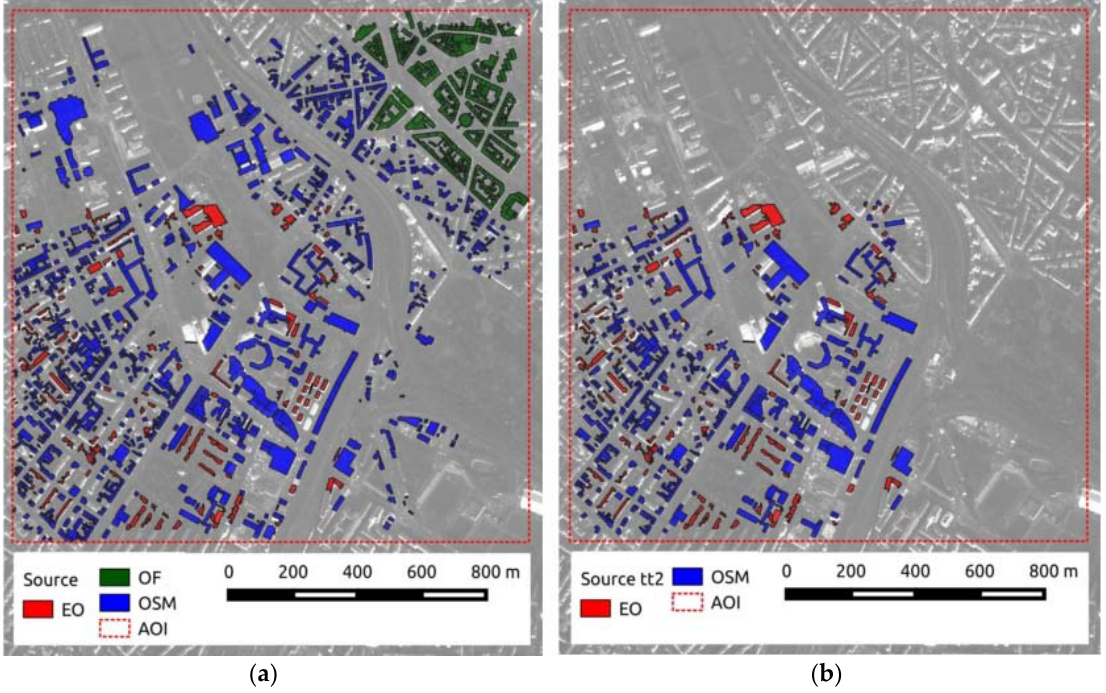
Figure 6. ( a ) Shows the integrated building inventory at release 3 (R3); ( b ) shows the database state at transaction time 2 after the update of Earth Observation (EO) geometries with geometries from OpenStreetMap